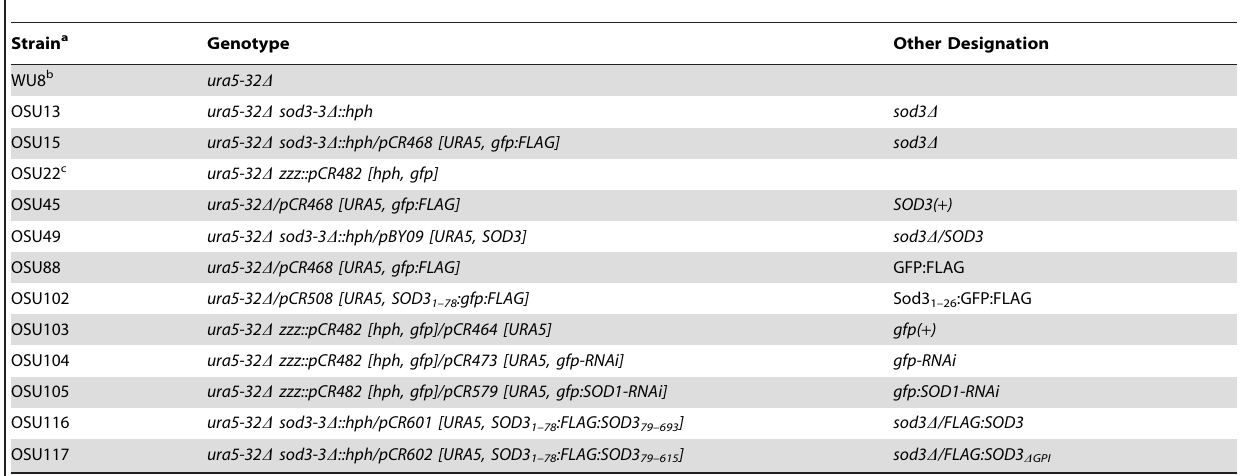
Table 1. Histoplasma capsulatum strains.